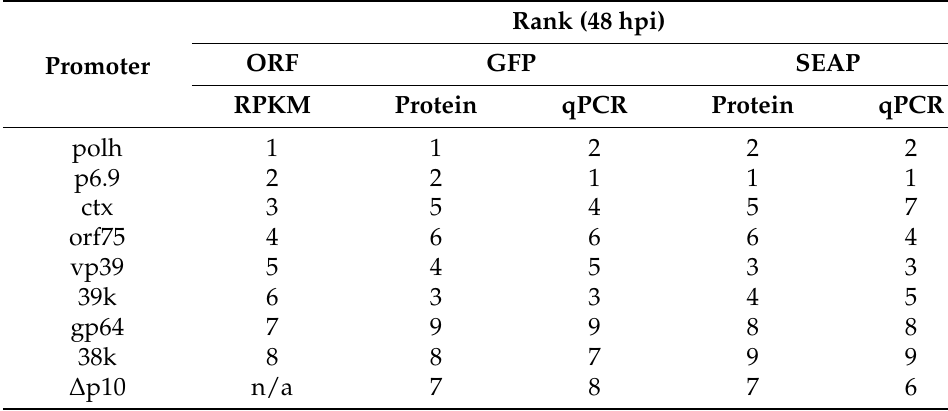
Figure 2. Production of intracellular GFP from selected Ac MNPV promoters. ( A ) Median fluorescence intensity measured using flow cytometry and ( B ) relative transcript abundance measured using RT- qPCR at various times post infection. Table 3. Promoters ranked by GFP and SEAP production at 48